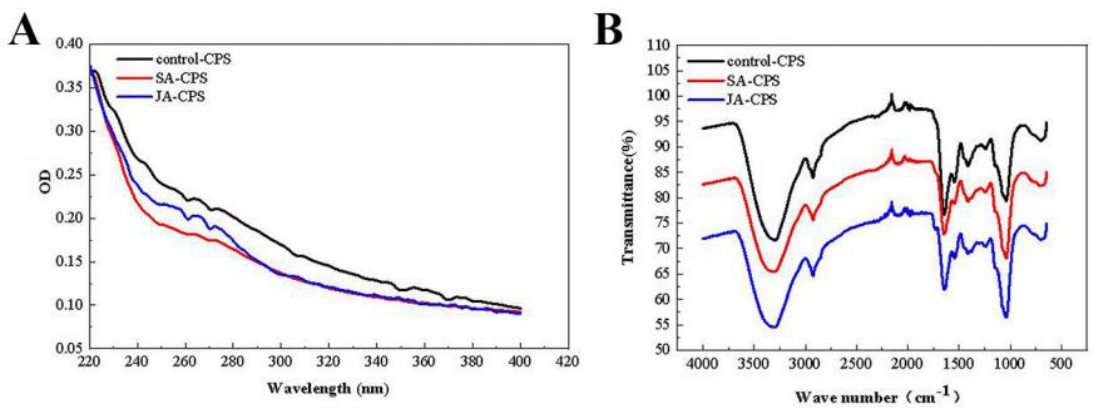
Figure 2. UV ( A ) and FT − IR ( B ) spectra of the control-CPS, SA-CPS, and JA-CPS.